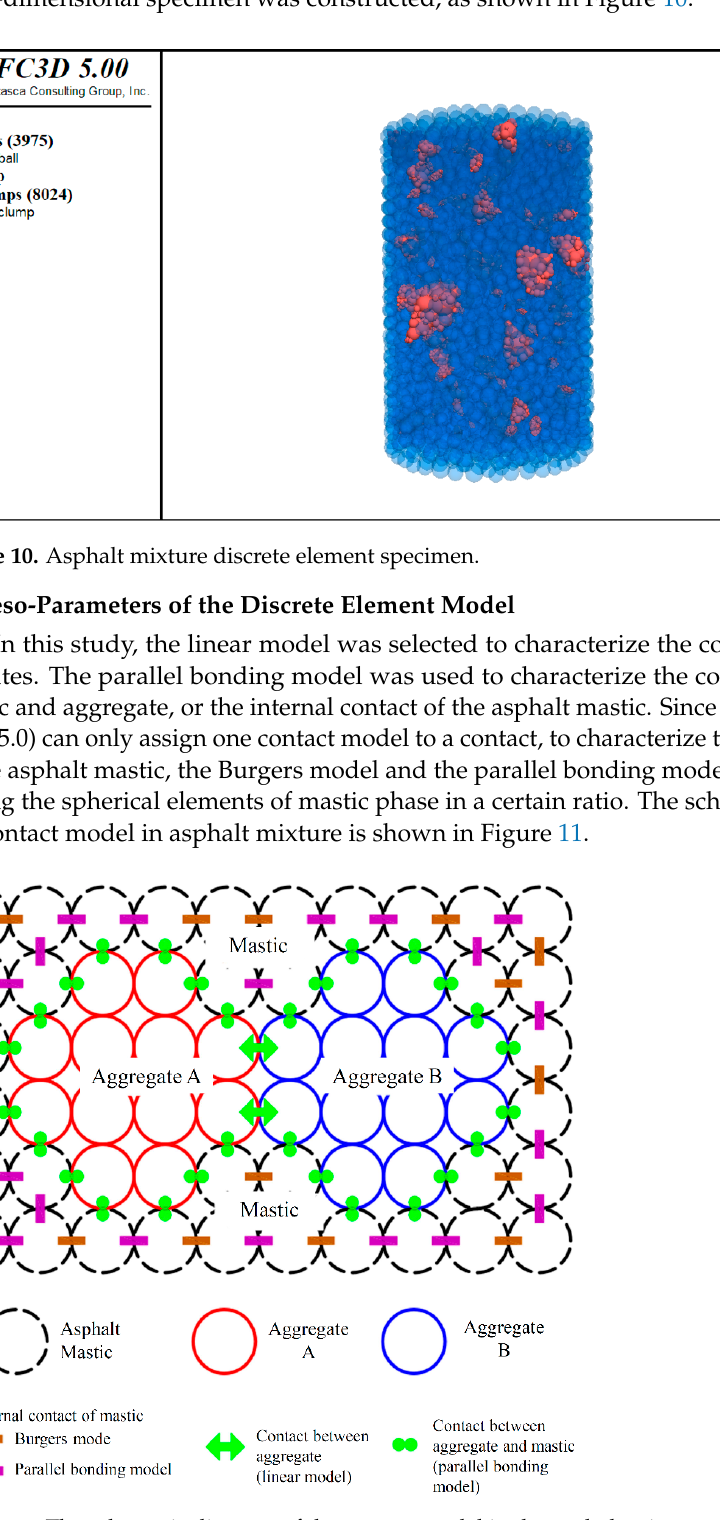
Figure 9. Aggregate distribution of asphalt mixture in DEM mode.